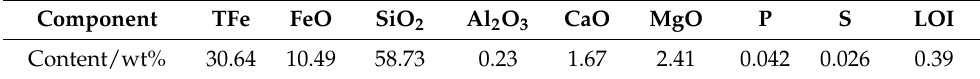
Table 1. The chemical multi-element analysis of the iron ore sample.